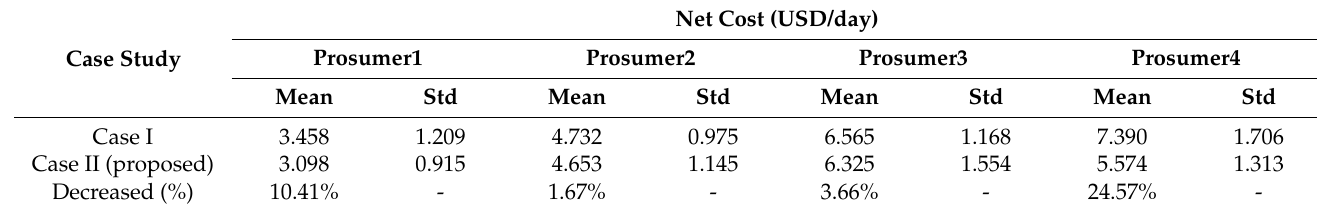
Table 6. The mean and standard deviation of the net cost of each